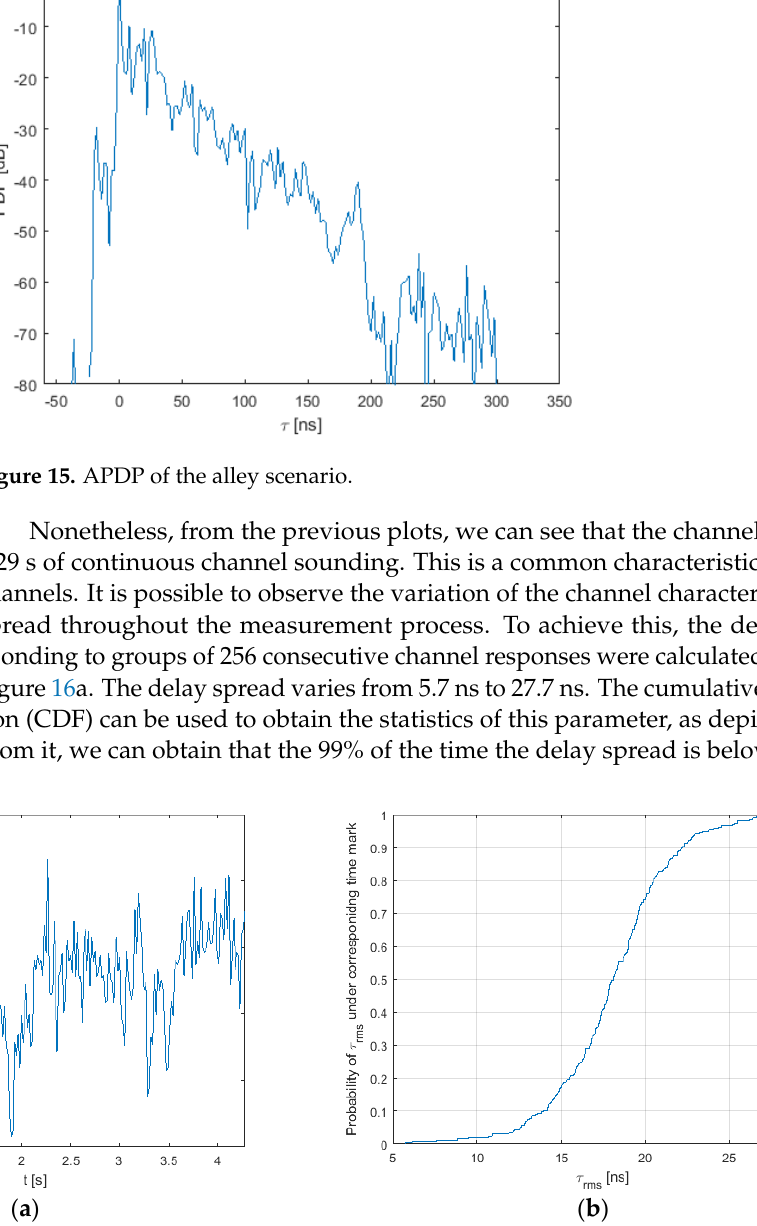
Figure 14. Measured PDPs shifted to align the main component.